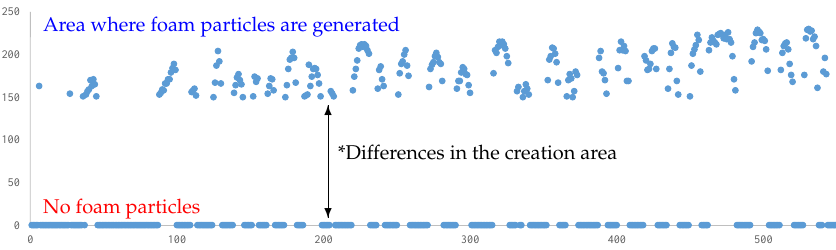
Figure 2. Curvature values at the evaluation region (see red line in Figure